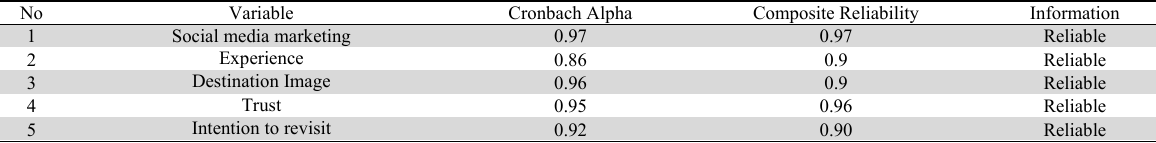
Calculation Results of Composite Reliability and Cronbach Alpha